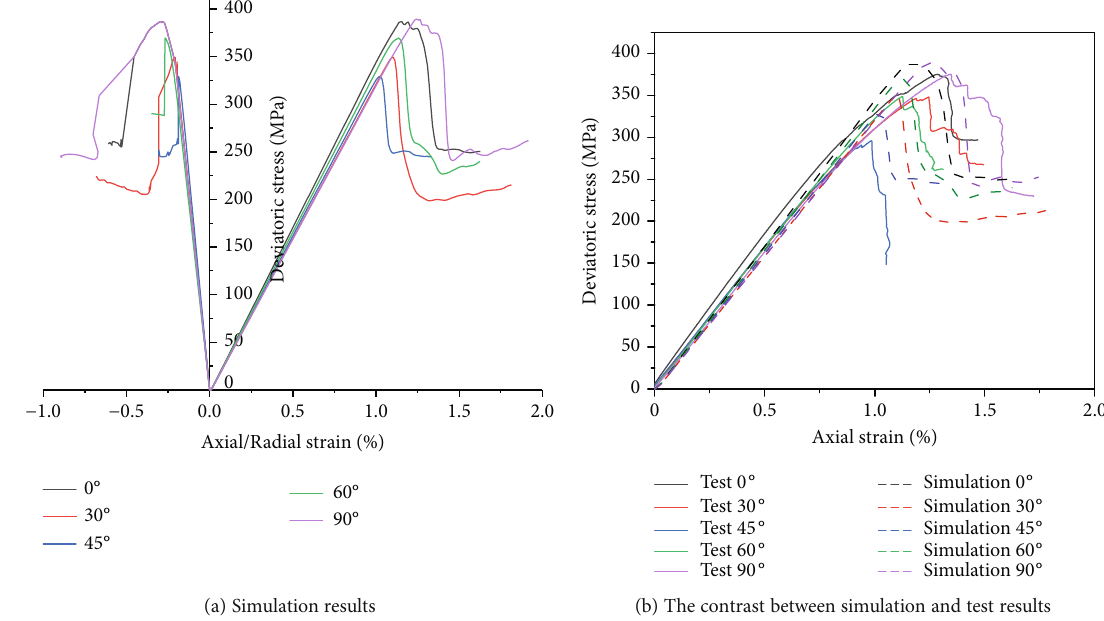
Figure 16: Simulation results of stress-strain relationship of cores with di ff erent bedding orientations and the contrast with test